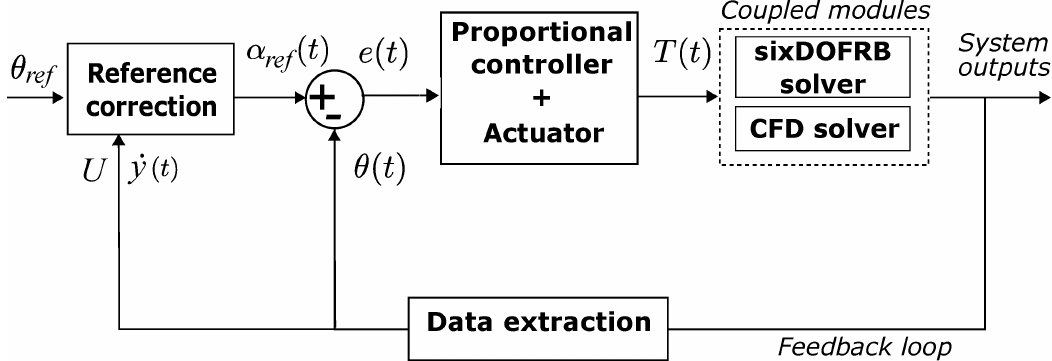
Figure 4. Close loop active control scheme. Dashed box groups the coupled modules that conform the equivalent to the plant of the system. T ( t ) stands for